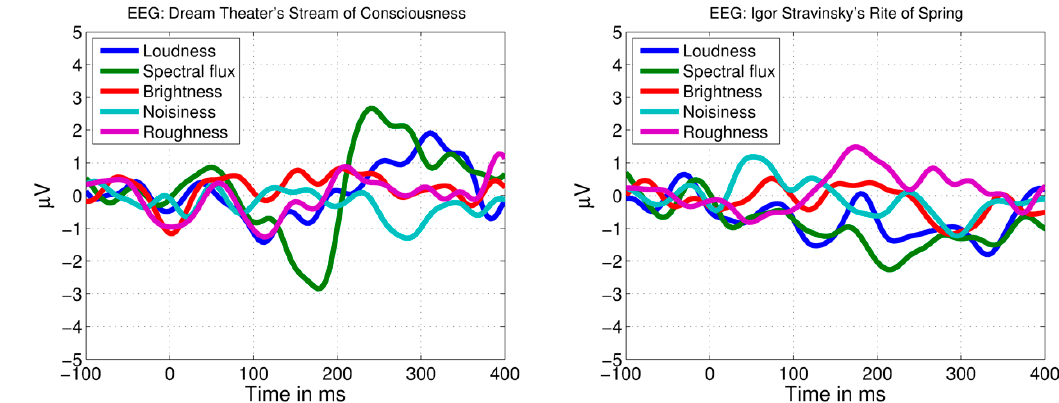
Figure 4. EEG responses to maximally distant acoustical feature increases. Average EEG responses are shown for Dream Theater’s Stream of Consciousness ( left ) and Igor Stravinsky’s Rite of Spring ( right ).